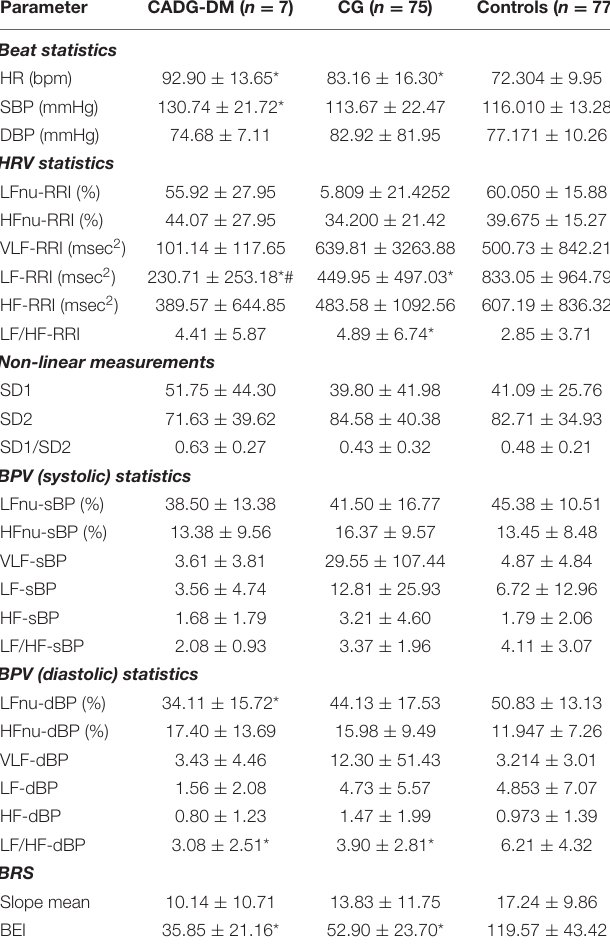
TABLE 6 | HRV and BPV in COVID-19 group with associated diseases (CADG). Parameter